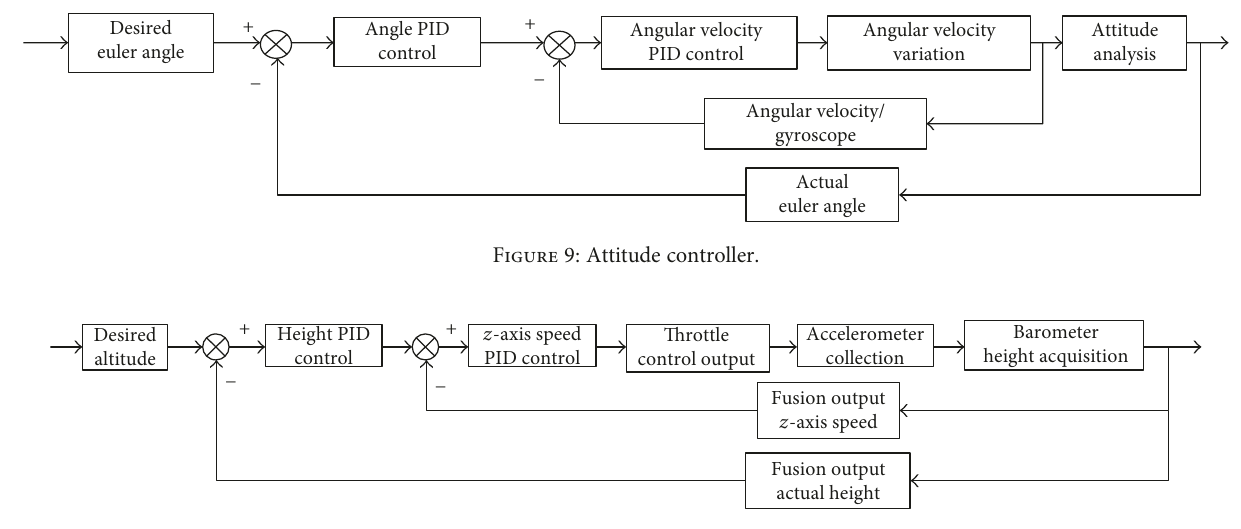
Figure 10: Position